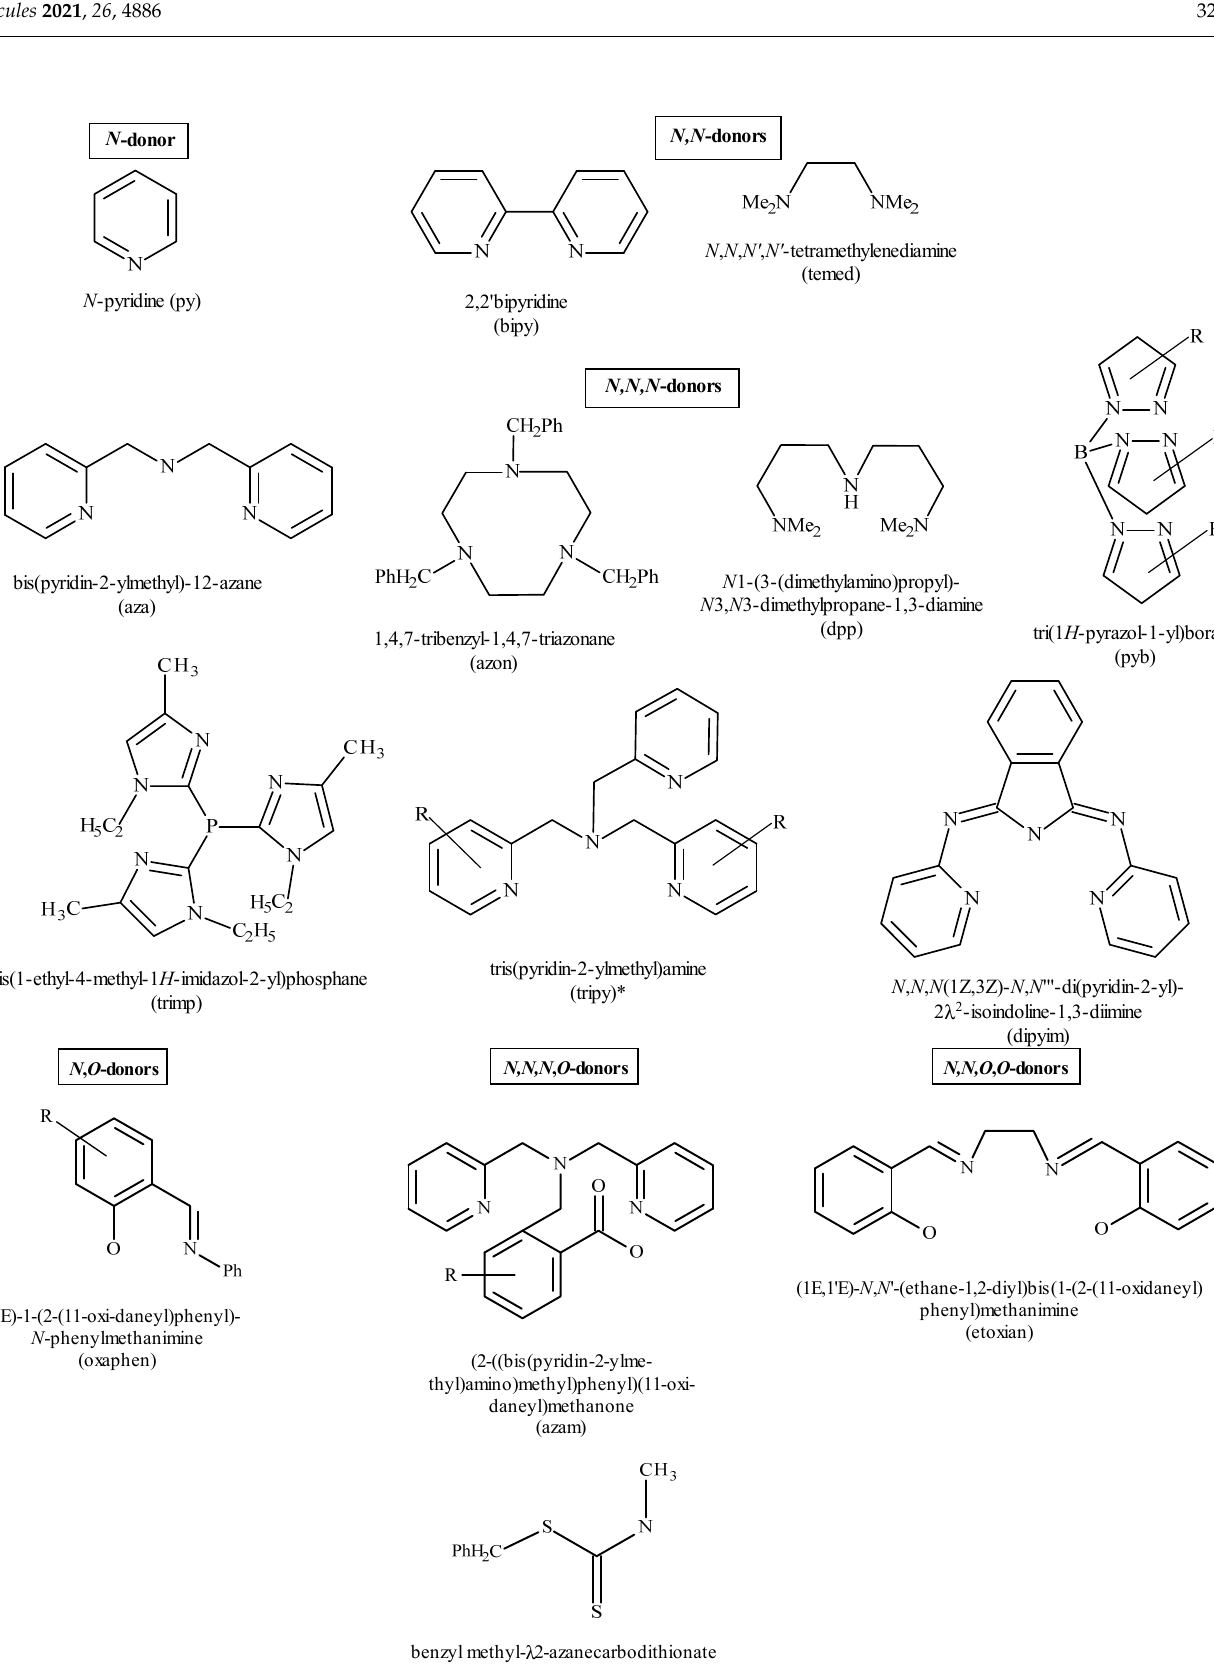
Figure 12. Type of ligands in flavonoid complexes. Asterix “*” indicates that ligand tripy could be in tridentate or tetradentate mode.